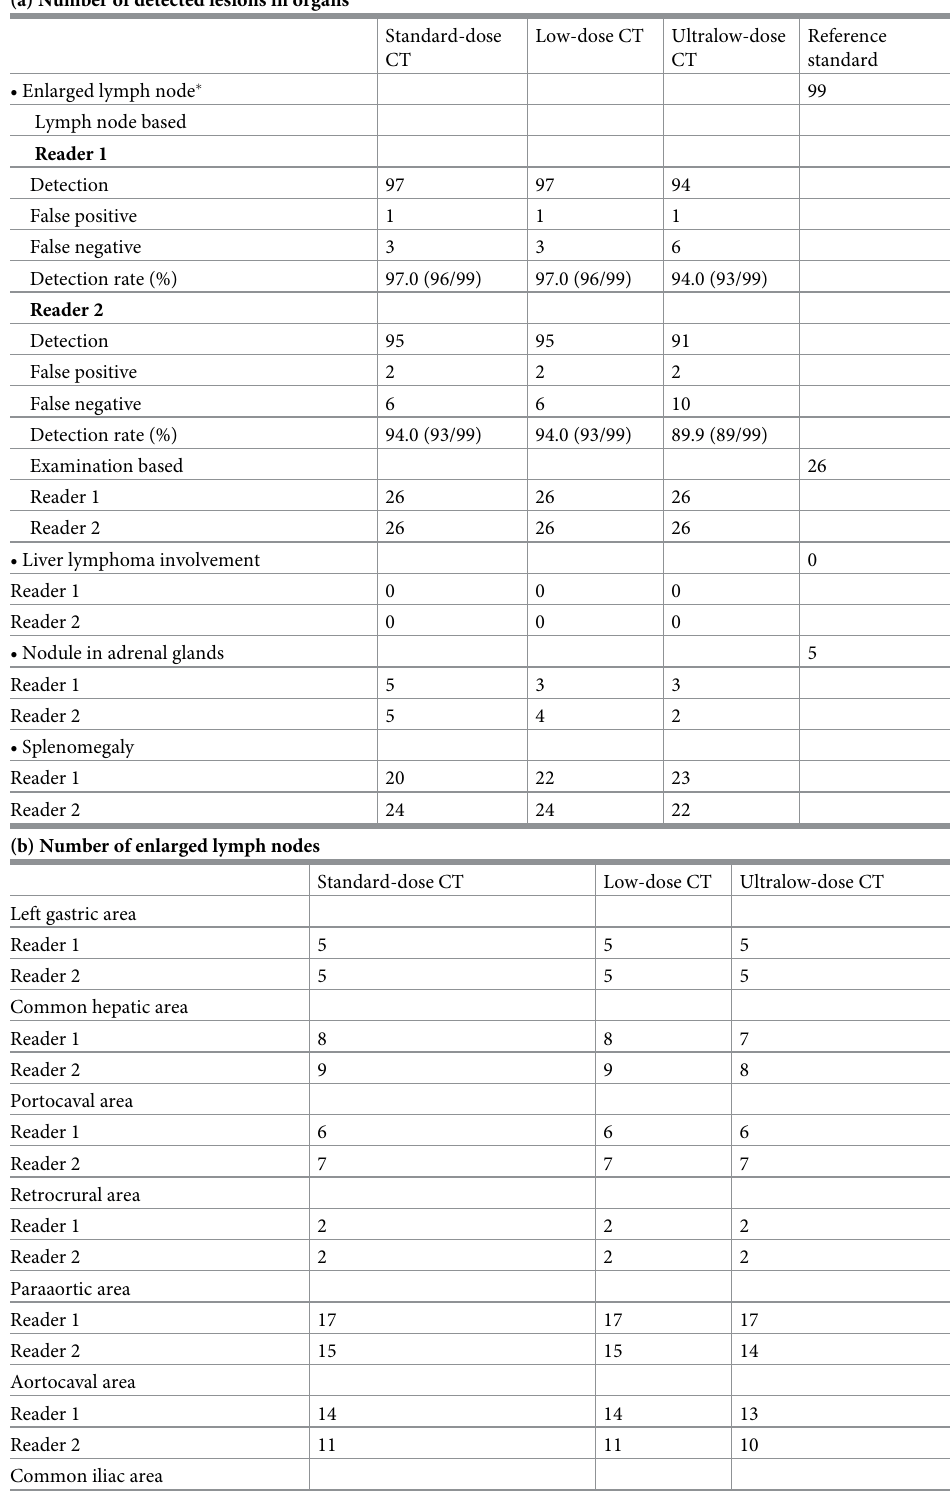
Table 4. Lesion detection in organs (a) and detailed enlarged lymph node (b) analysis. (a) Number of detected lesions in organs